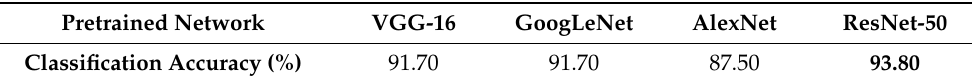
Table 8. Performance comparison of pretrained models with optimal hyperparameters.